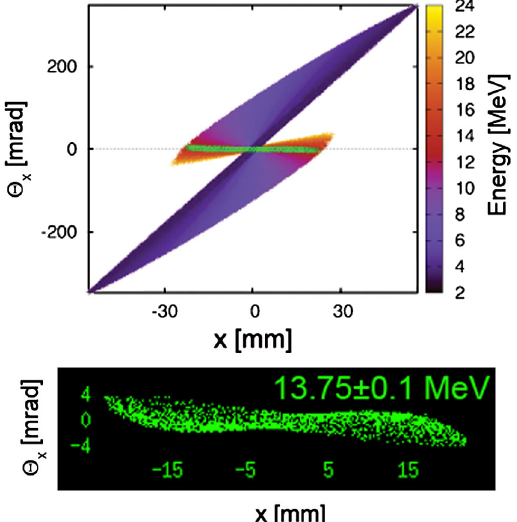
FIG. 10. A phase-space plot for all laser accelerated protons passing through the 8.5 T field. The green points (enlarged in lower image) highlight the 13 : 75 (cid:5) 0 : 1 MeV protons. The chro- matic aberration results in divergent beams (yellow points), collimated beams (green points), focused beams (light-purple points), and beams that diverge after a focus (dark-purple points) at the film